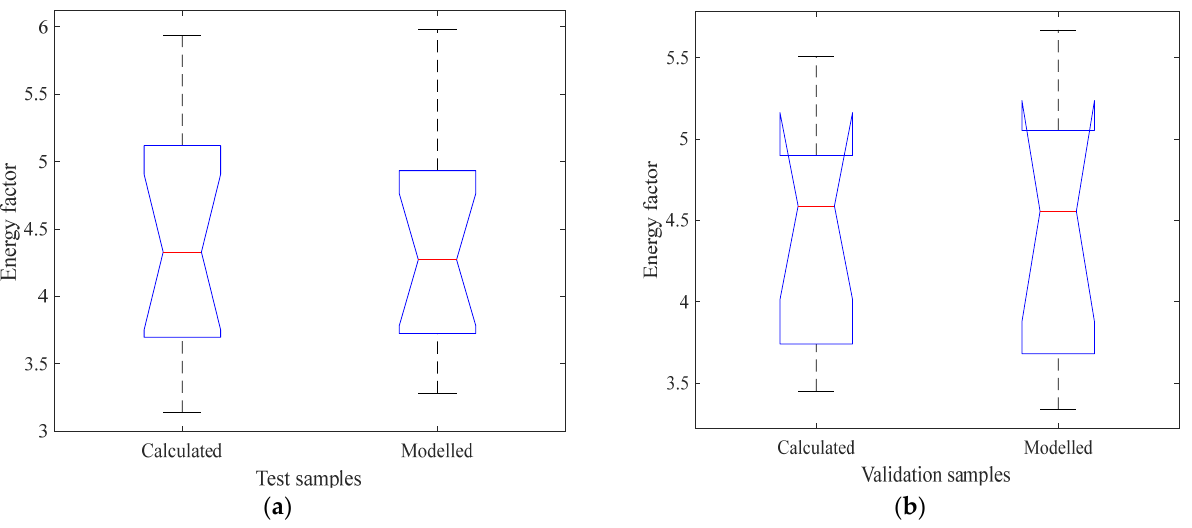
Figure 14. ( a ): ANOVA plot with the test dataset , ( b ): ANOVA plot with the validation dataset .